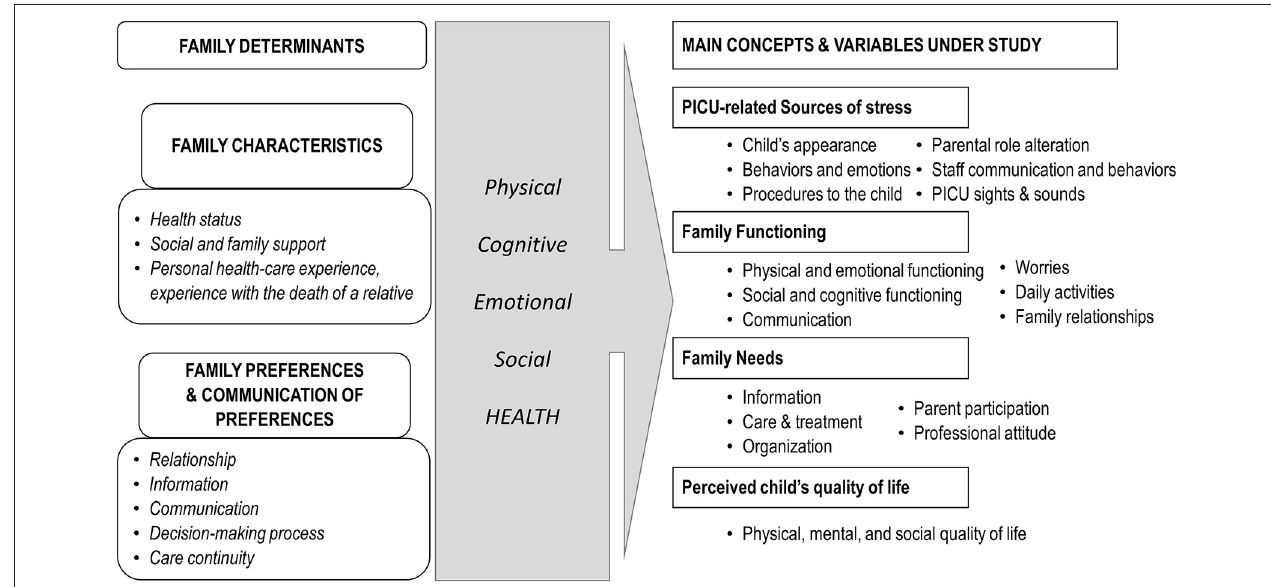
FIGURE 1 | Theoretical model of the study. Illustration of links between the family determinants (4, 22), the domains of family health (23) and the concepts and variables under study (